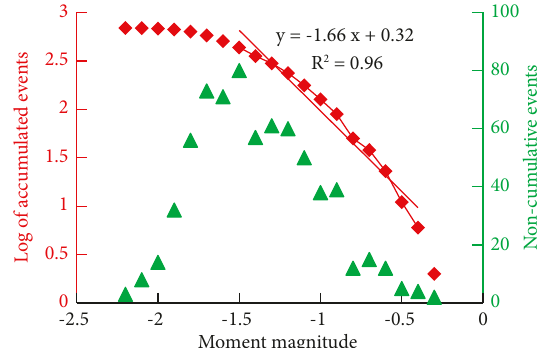
Figure 18: Moment magnitude-frequency curve of the traffic